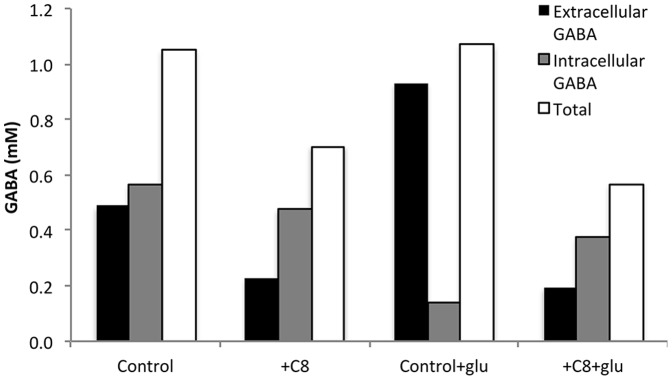
Supplementing glutamate increases GABA export; however, addition of C8 reduces GABA accumulation and export.GABA measurements of MG1655 during log phase growth in MOPS with 2% dextrose at 37°C, 150 rpm. All concentrations are 10 mM. GABA: γ-amino butyric acid.